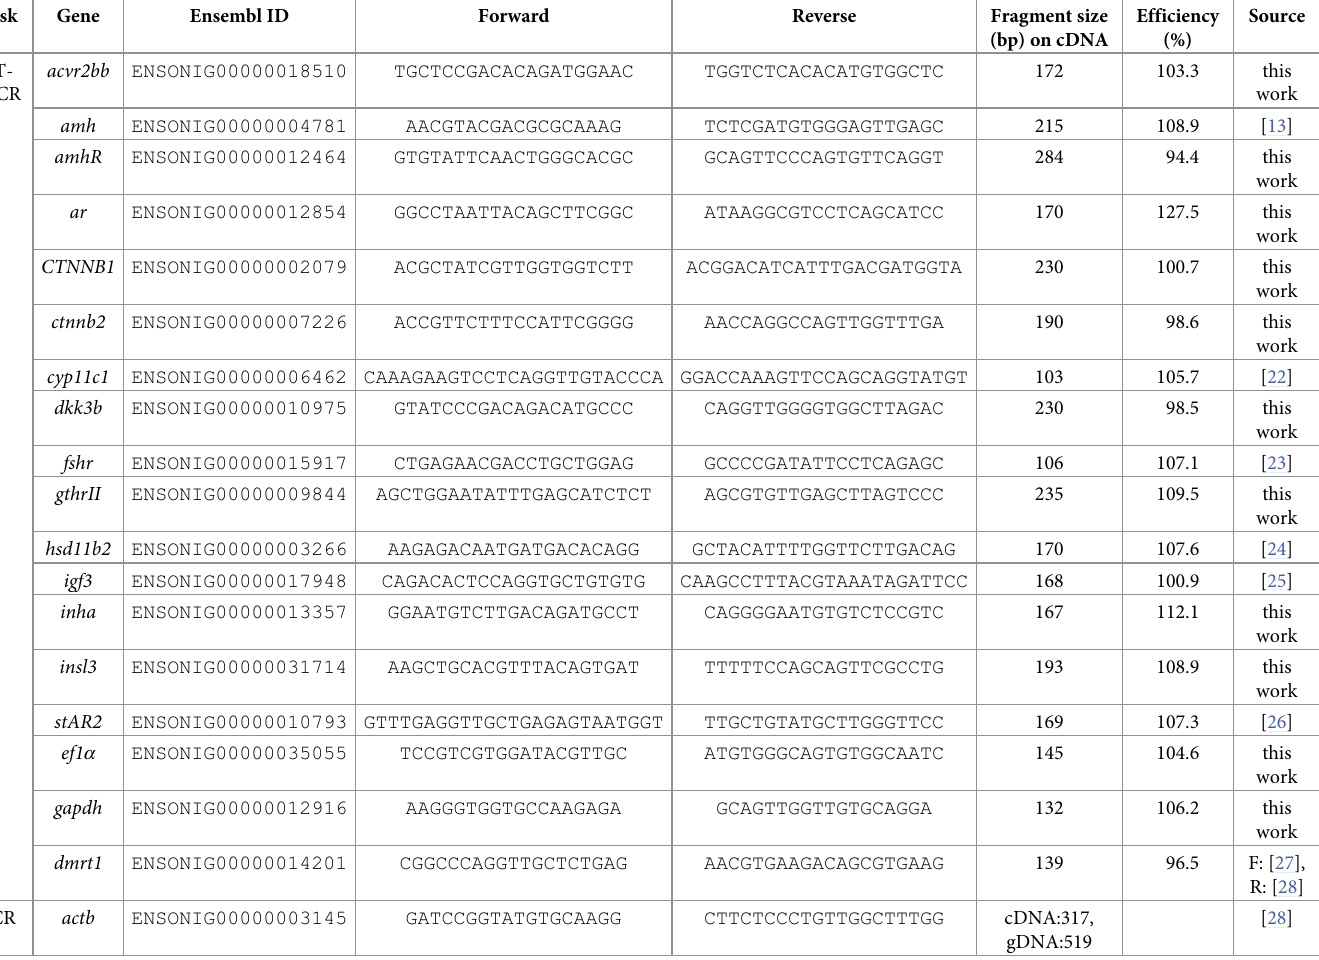
Table 2. Primers for RT-qPCR and PCR.